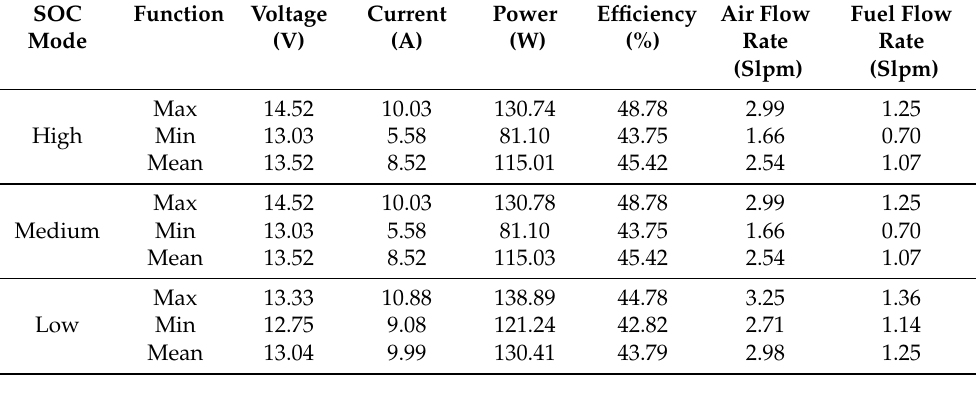
Table 10. FC response in high, medium and low SOC full-active hybrid simulation.